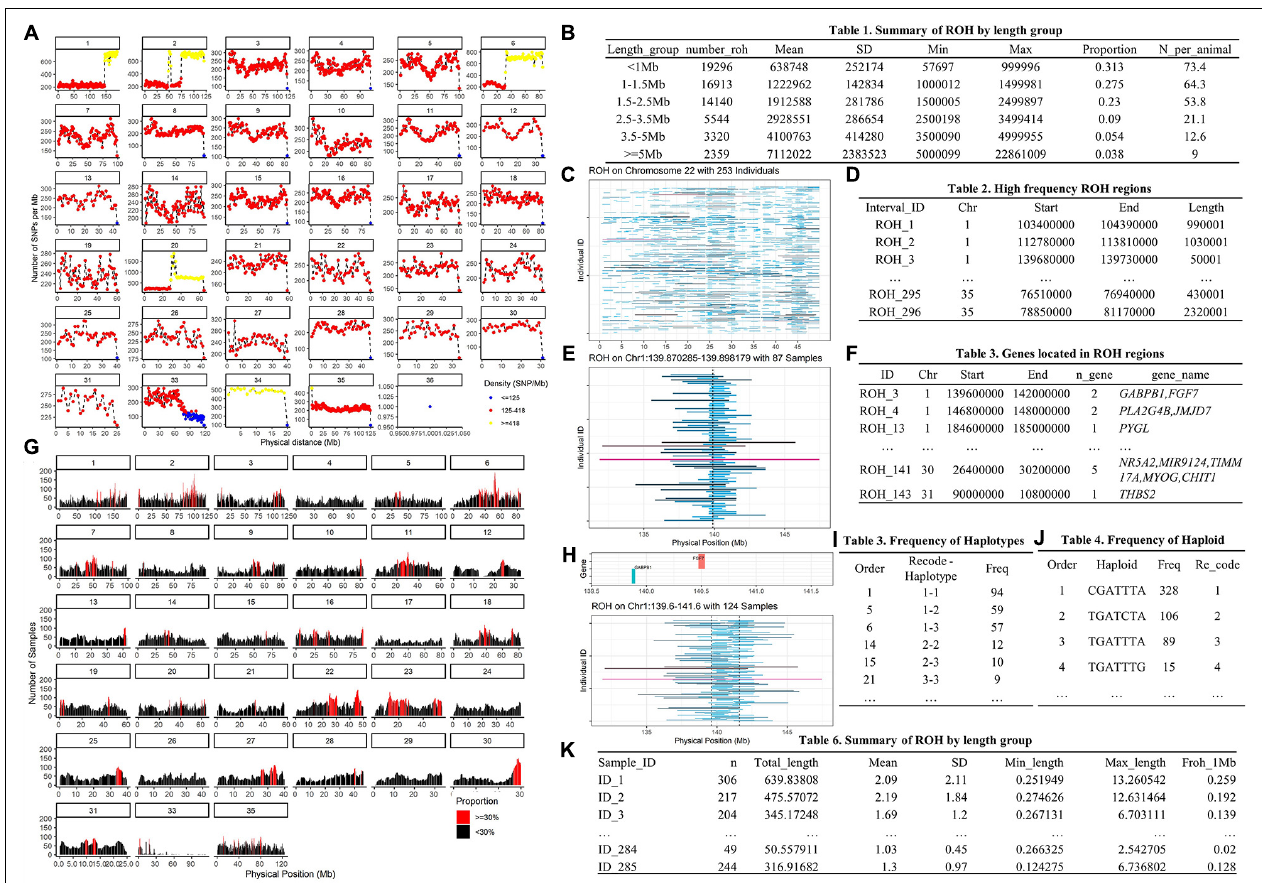
FIGURE 7 | The main outputs of example 2. Panel (A) is SNP density distribution plot; panel (B) is brief summary of ROH by length group; panel (C) is plot of ROH on Chromosome 22; panel (D) is the high frequency ROH regions list; panel (E) is plot of ROHs on Chr1:139.6-141.6 Mb; panel (F) is genes annotation list of ROH regions; panel (G) is the ROH frequency distribution plot; panel (H) is plot of ROHs that overlap to the GABPB1 gene; panel (I) is the frequency of haplotypes on GABPB1 Gene; panel (J) is the frequency of haploids on the GABPB1 gene; and panel (K) is the list of ROHs-based inbreeding